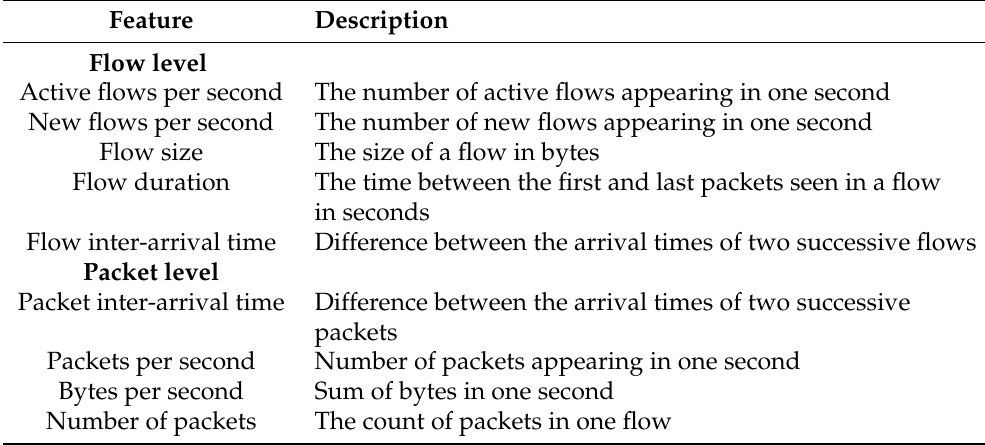
Table 3. Studied features.